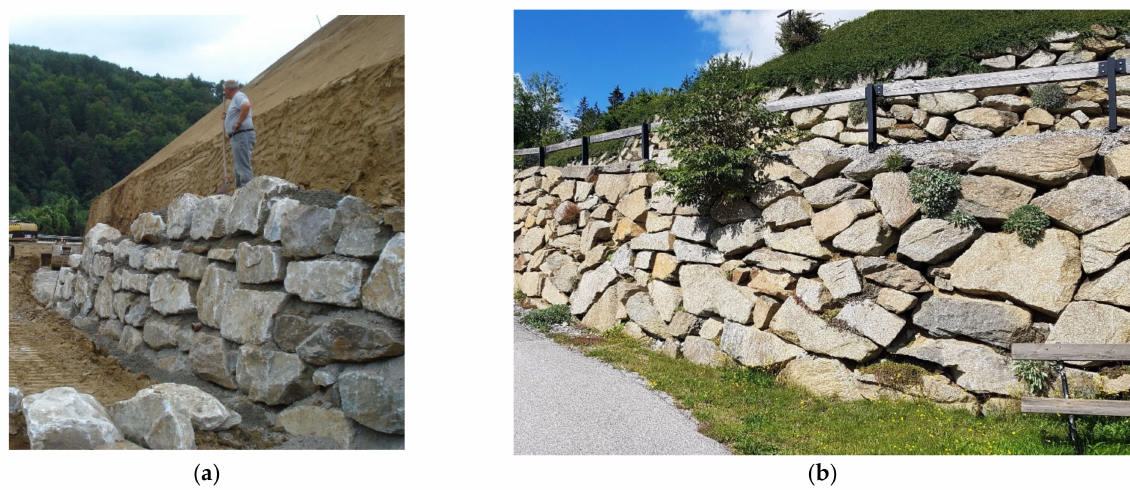
Figure 2. Manufacture of a piled mortared stone support body ( a ) and a piled supportive stone construction ( b